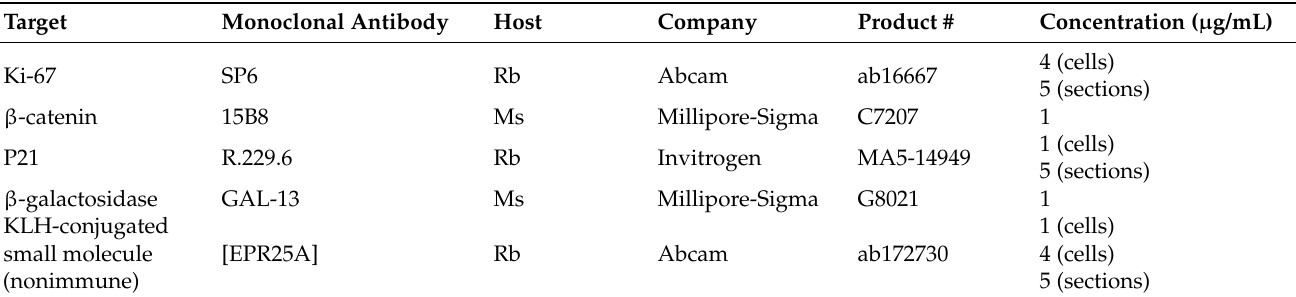
Table 2. Antibodies used in immunolabeling